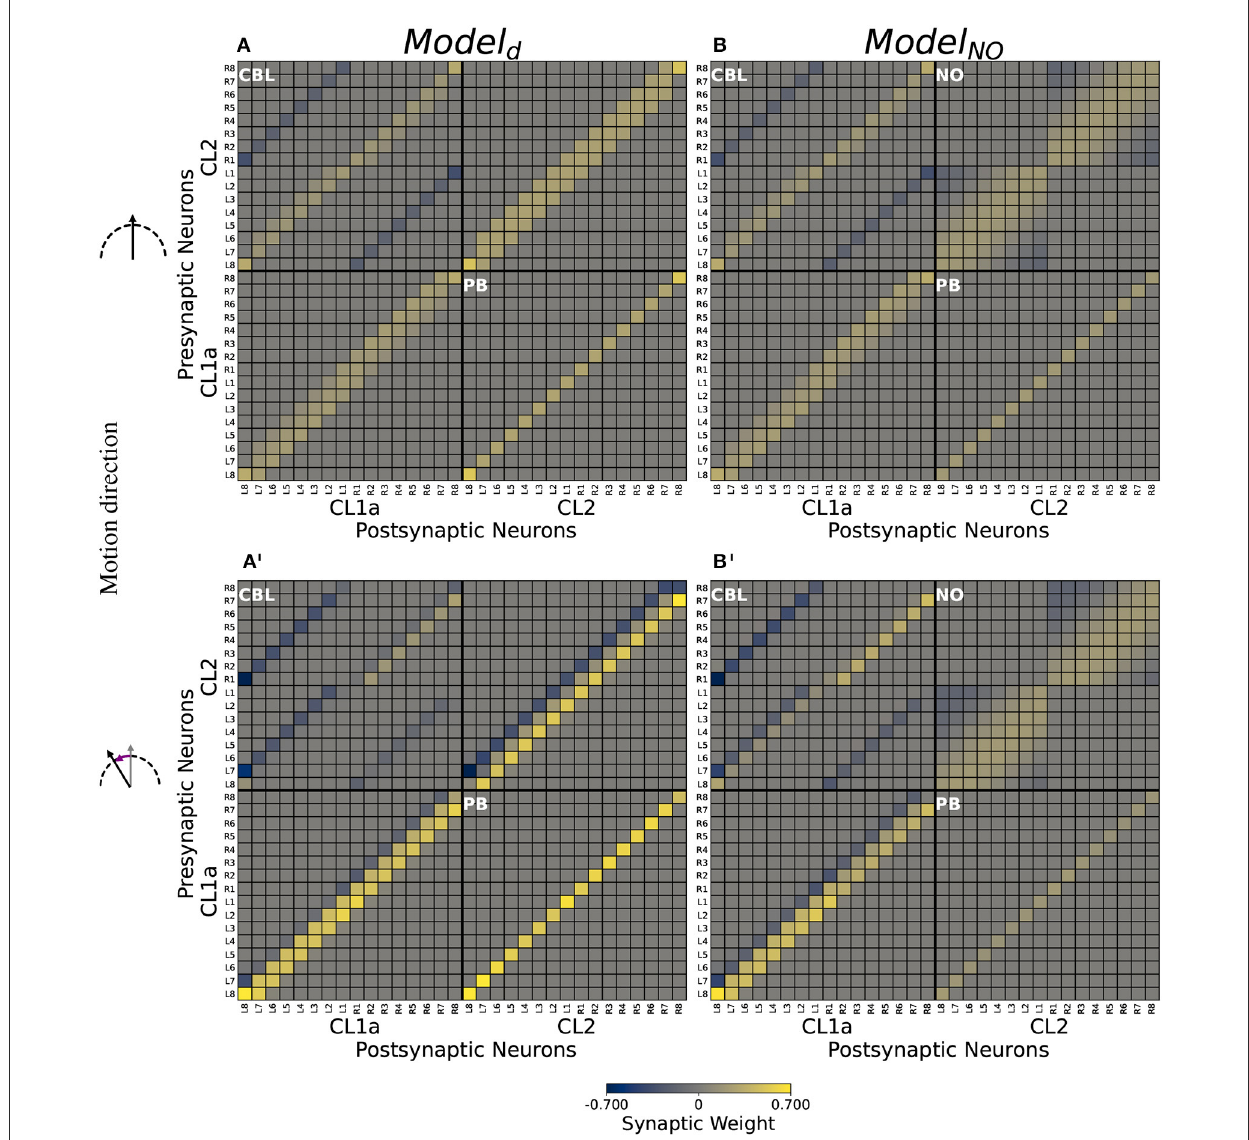
FIGURE6 Computational model connectivities. (A, B) Connectivity matrices M d and M NO optimized for compass state maintenance. (A’, B’) Modulated connectivity matrices M d and M NO optimized for compass state shifts, depicted for left turns. For right turns, resulting modulated matrices are identical but with each quadrant rotated by 180 ◦ . Excitatory synapses are depicted in yellow, inhibitory synapses in blue. Neurons are indexed via the PB column (L8-R8) in which they arborize. Values are clipped at ± 0.7 for better